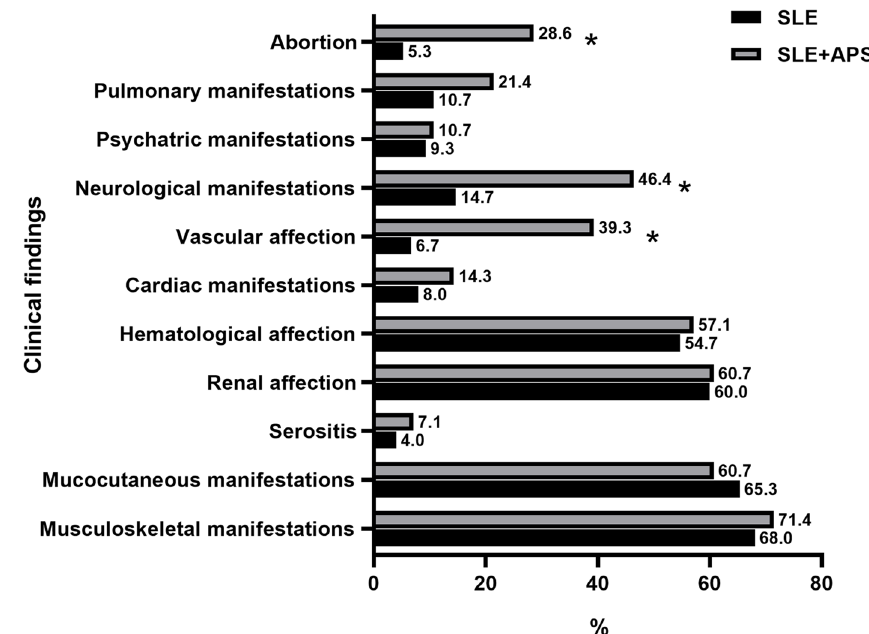
Data were presented as number (percentage)